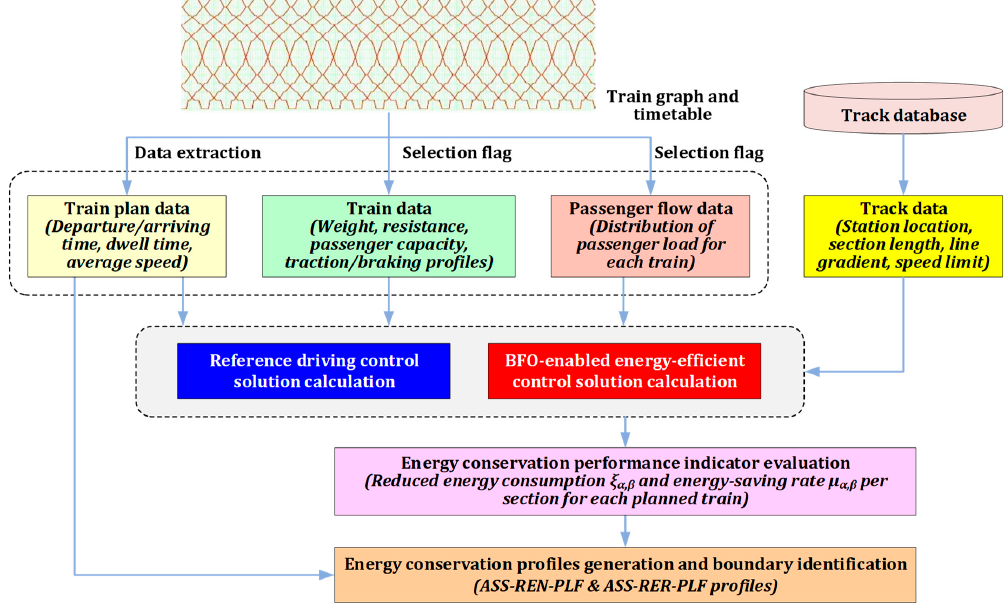
Figure 4. Flowchart of the energy conservation profile generation method.